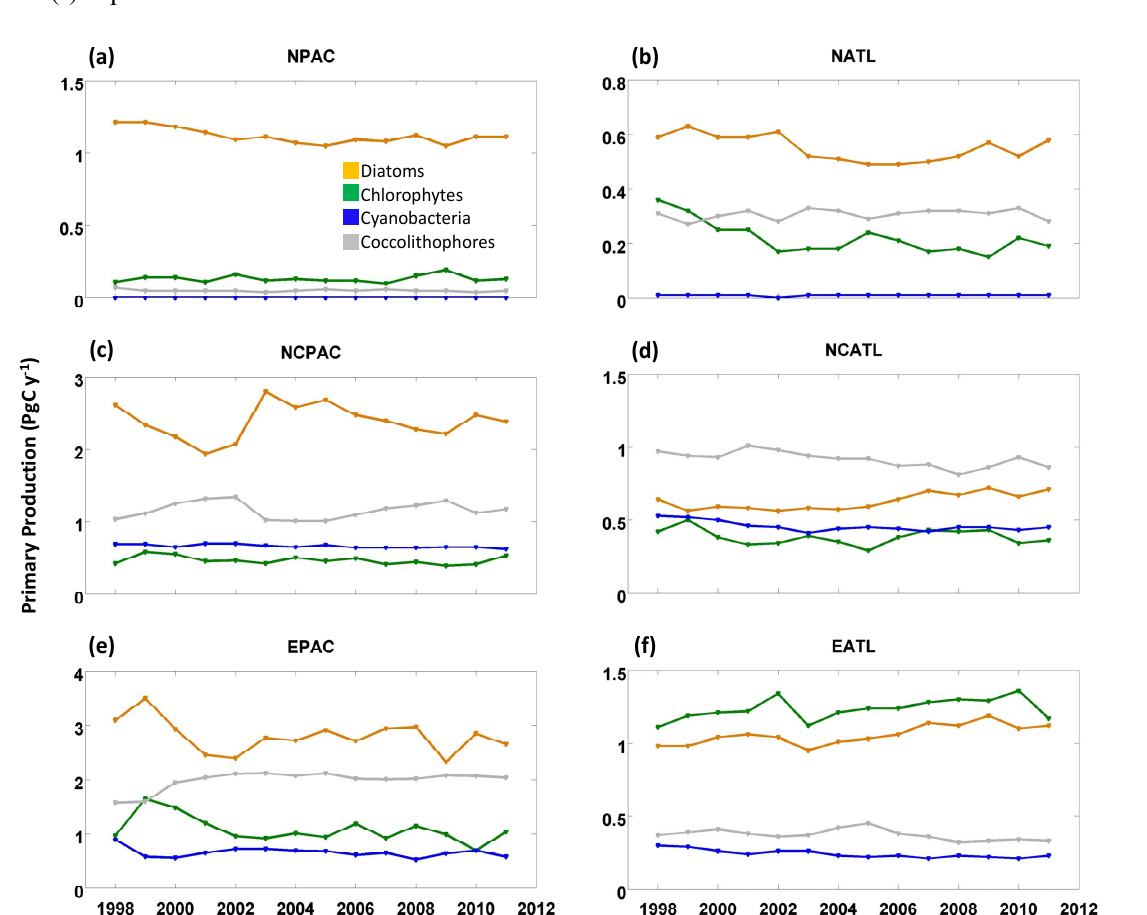
Figure 6. Interannual variation of model class-specific primary production for diatoms, chlorophytes, cyanobacteria and coccolithophores in ( a ) North Pacific, ( b ) North Atlantic, ( c ) North Central Pacific, ( d ) North Central Atlantic, ( e ) Equatorial Pacific and ( f ) Equatorial